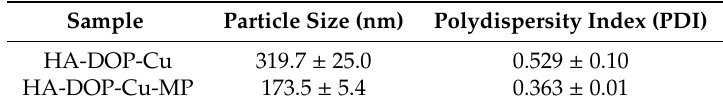
Table 1. Particle sizes of dopamine-modified hyaluronic acid (HA-DOP)-Cu-MP ( n = 3).